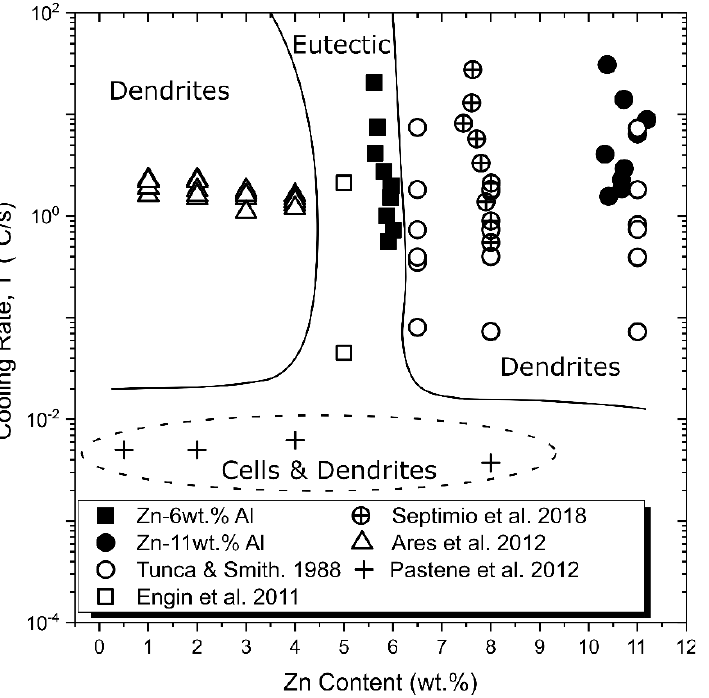
Figure 18. Coupled zone as a function of solidification cooling rate and alloy composition for Zn–Al alloys.